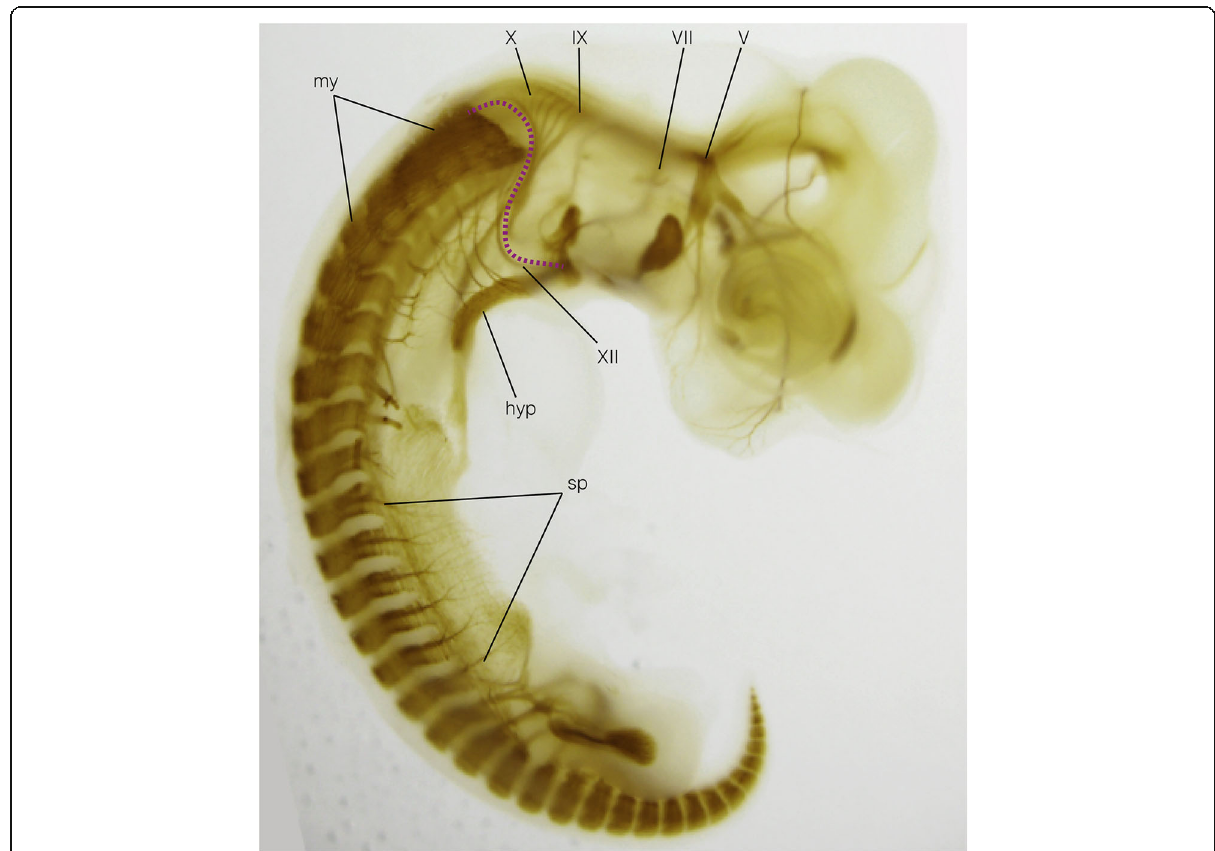
Fig. 7 Late pharyngula of the Chinese soft-shelled turtle, Pelodiscus sinensis , immunostained to show peripheral nervous system and muscle primordia. The head – trunk interface is shown by the magenta broken line, delineating the spinal and branchiomeric nerves from each other. Note also that the myotomes are restricted to the trunk region of the embryo. Hyp, hypobranchial muscle anlage; IX, glossopharyngeal nerve; my, myotomes; sp., spinal nerves; V, trigeminal nerve; VII, facial nerve; X, vagus nerve; XII, hypoglossal